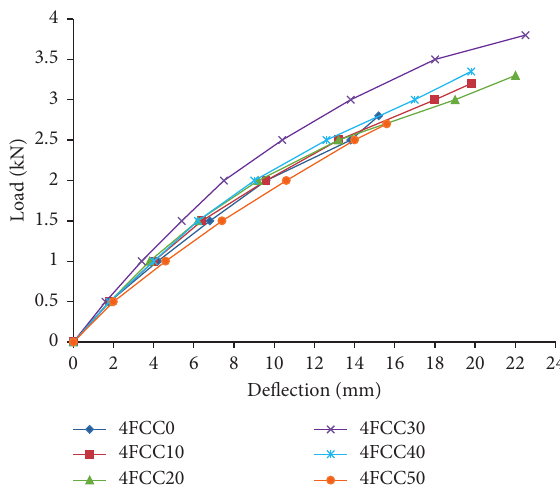
Figure 8: Load vs. deflection for ferrocement laminates with volume fraction 3.77%.